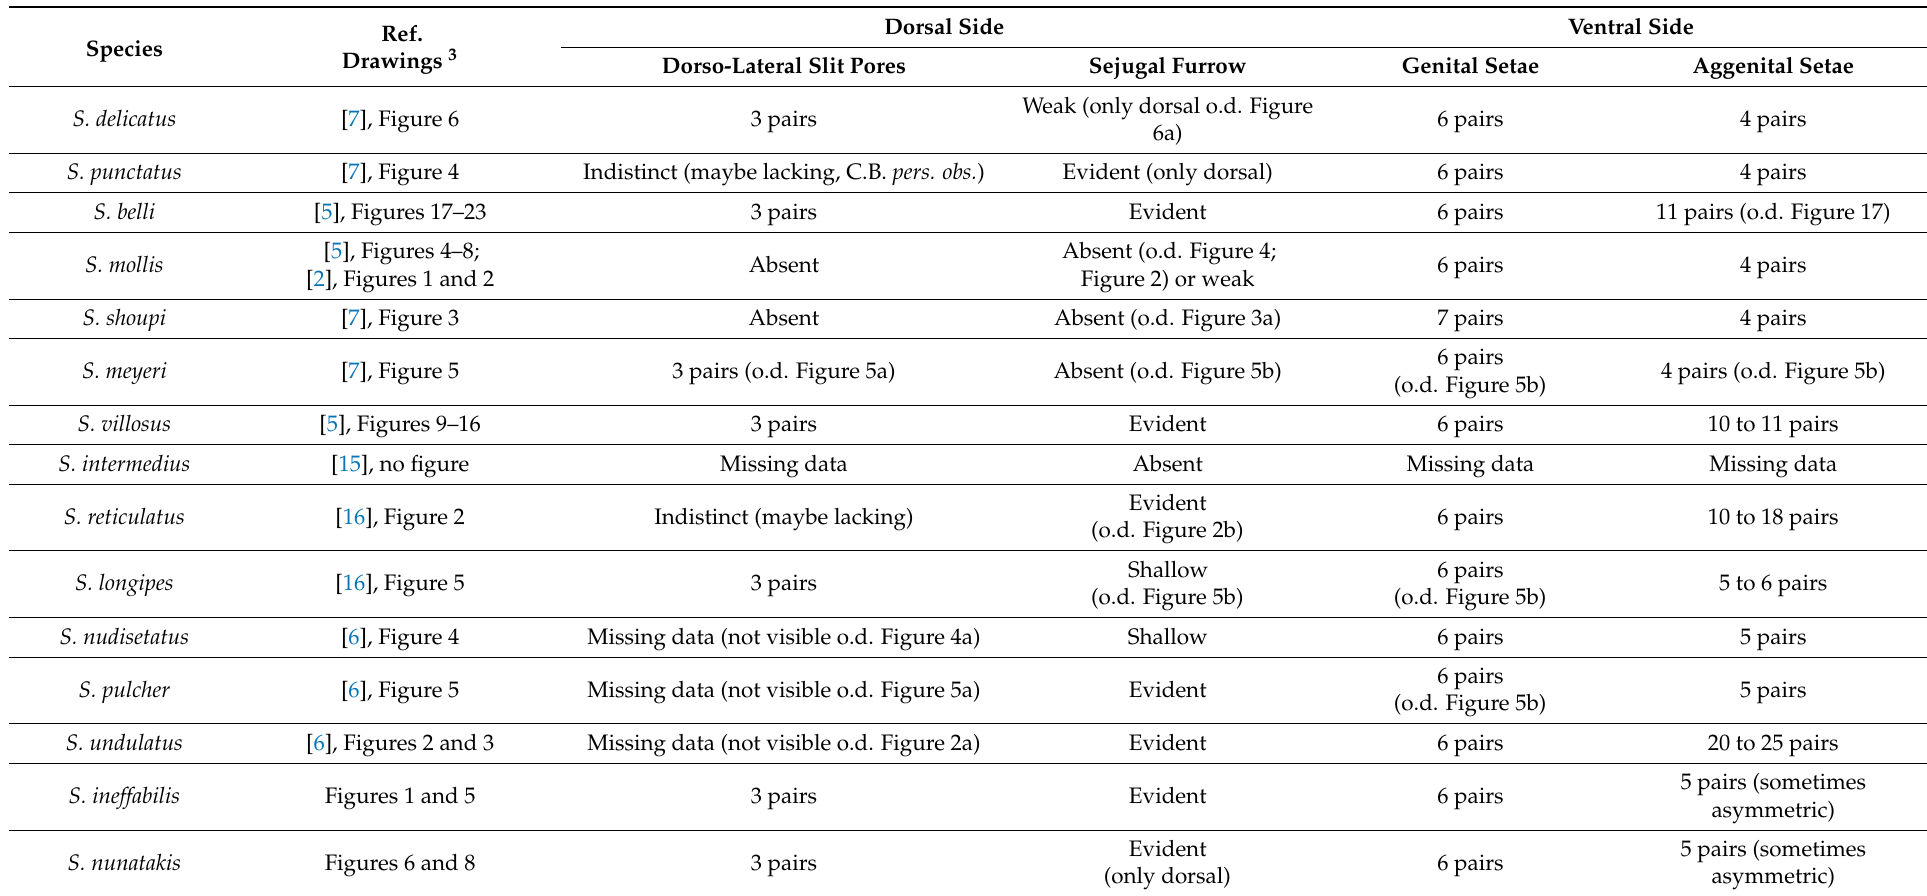
Table A4. Synoptic table of the Antarctic and sub-Antarctic Stereotydeus species with particular attention to the morphological characteristics useful for the identification of the different species. When a characteristic was not in the main text of the description, the reference drawings were used to extrapolate the data and mentioned in the table; on drawing (o.d.); personal observations ( pers. obs.